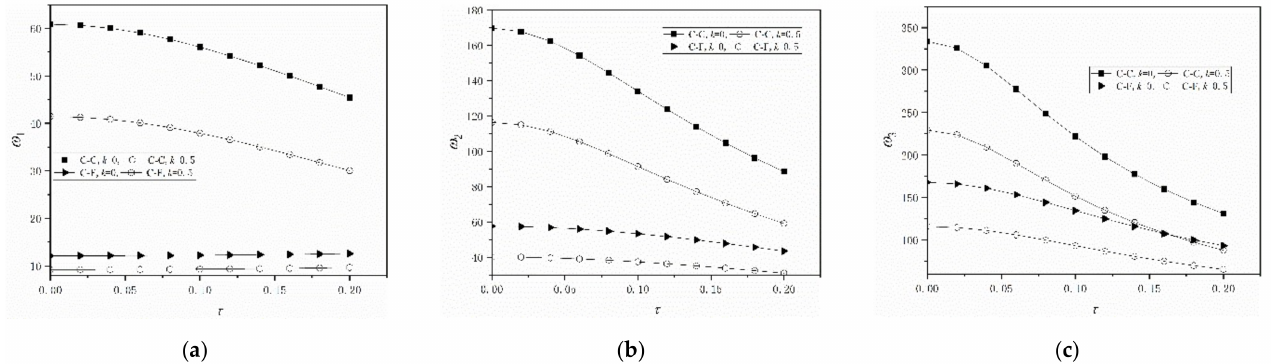
Figure 7. The relationship between dimensionless natural frequencies and the nonlocal parameter under two different boundary conditions (Reddy plate). ( a ) The first-order frequencies; ( b ) The second-order frequencies; ( c ) The third-order frequencies.